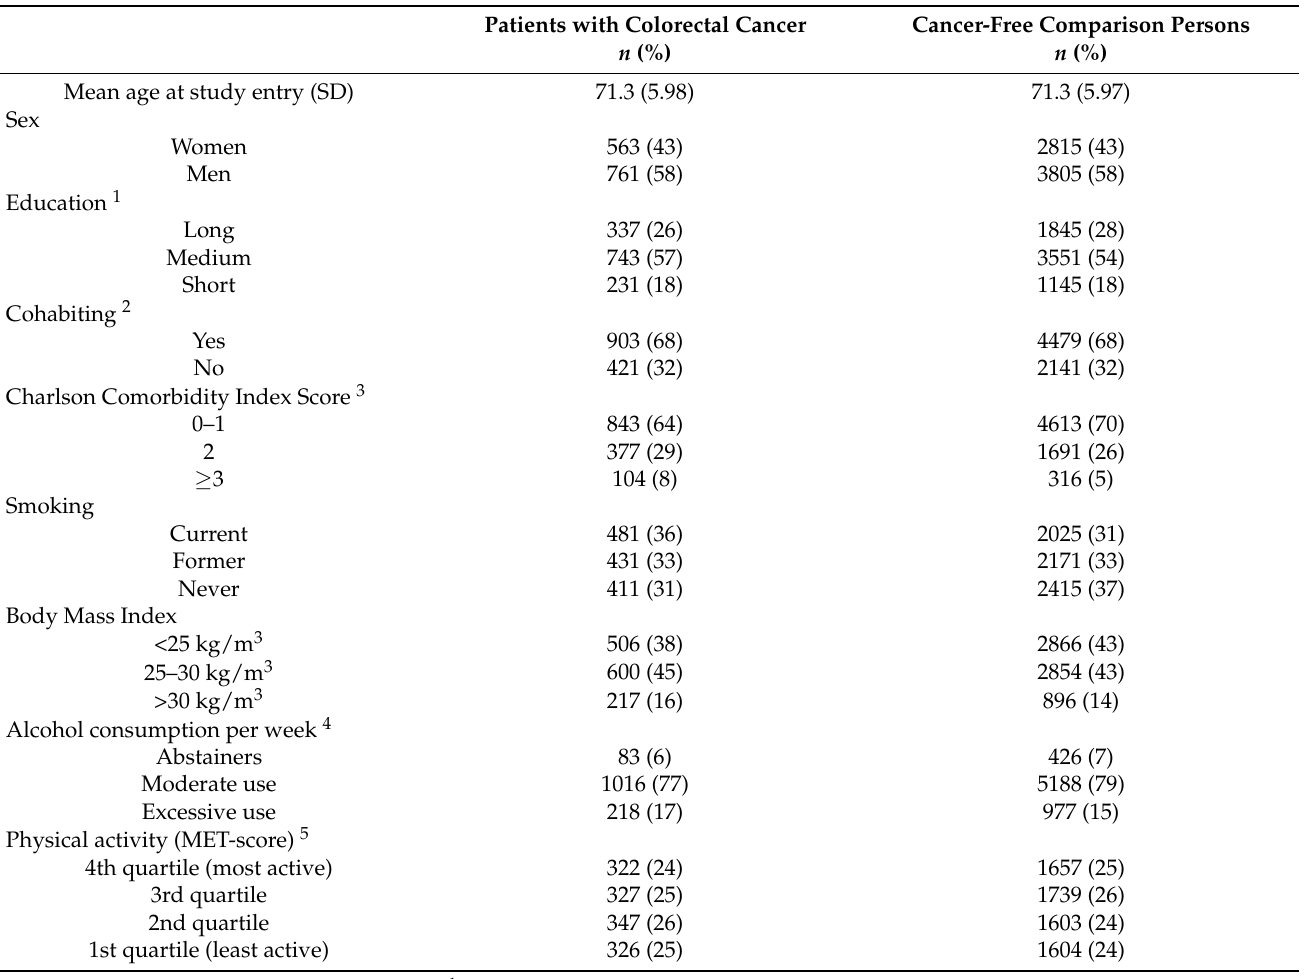
Table 1. Sociodemographic and comorbidity at time of study entry and lifestyle factors reported at time of enrollment among 1324 patients with colorectal cancer and 6620 matched comparison persons at time of enrollment in the Danish Diet, Cancer and Health